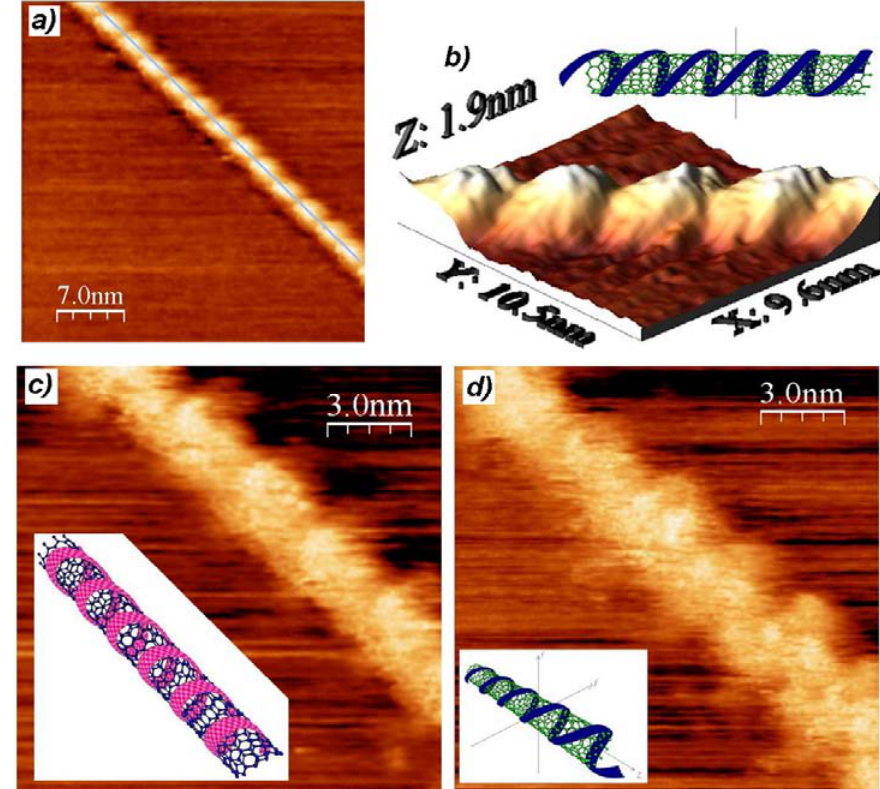
Figure 6. (a) Polymer covered nanotube imaged by UHV-STM. Scan obtained at V = − 500 mV and I = 0.300 nA. The line of the structure is used for profile analysis. SAMPLE (b) 3-D image of a P3HT covered nanotube imaged by UHV-STM. (c) Corresponding 2-D = − 500 mV and I = 0.300 nA. The image has been filtered image. Scan obtained at V SAMPLE with a Gaussian smooth on the Y axis and the Z colour scale has been changed to highlight the details of the polymer wrapping. Inset: Polymer wrapping generated